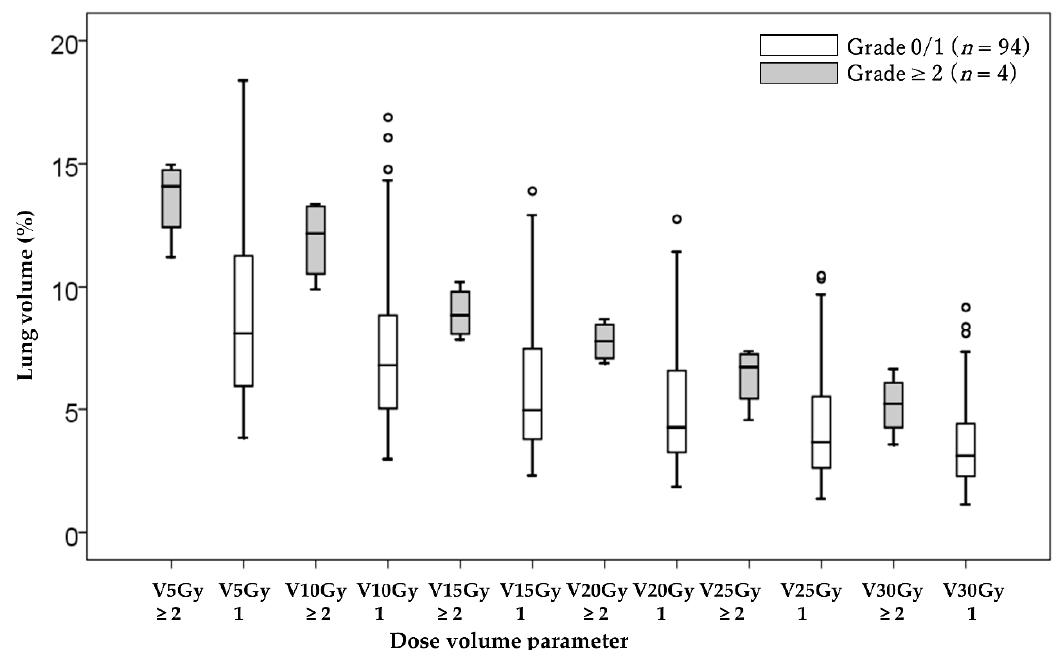
Figure 2. Comparison of the dose–volume parameter of all lungs between patients with grade 0–1 and grade 2–3 radiation pneumonitis. Abbreviation; Vx: normal lung volume irradiated at least xGy (relative biological effectiveness); RBE: relative biological effectiveness.